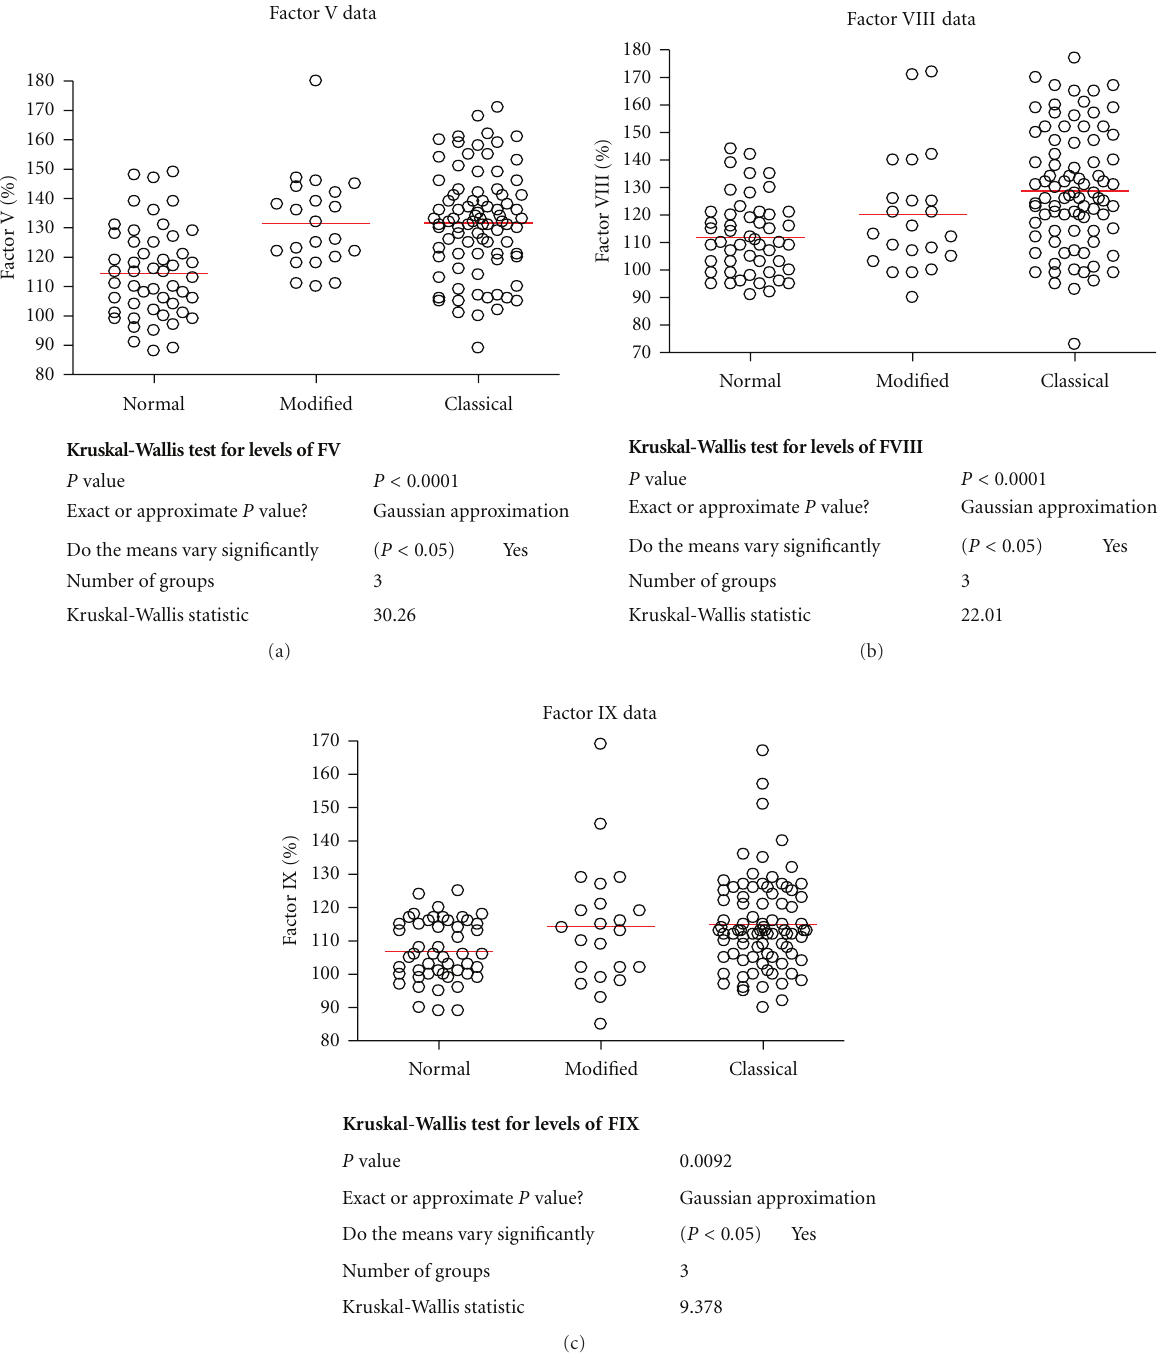
Figure 1: (a) Graph comparing FV levels in di ff ering groups within the study, (b) graph comparing FVIII levels in di ff ering groups within the study, and (c) graph comparing F IX levels in di ff ering groups within the study.